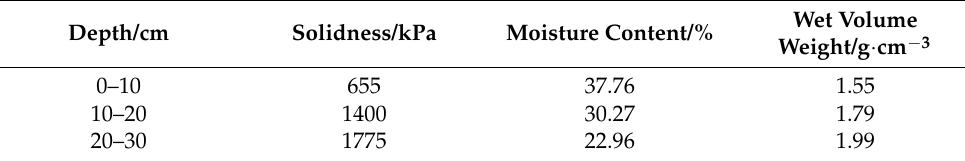
Figure 1. Location map of the study area. Table 1. Original solidity, water content, and wet bulk density of soil samples.